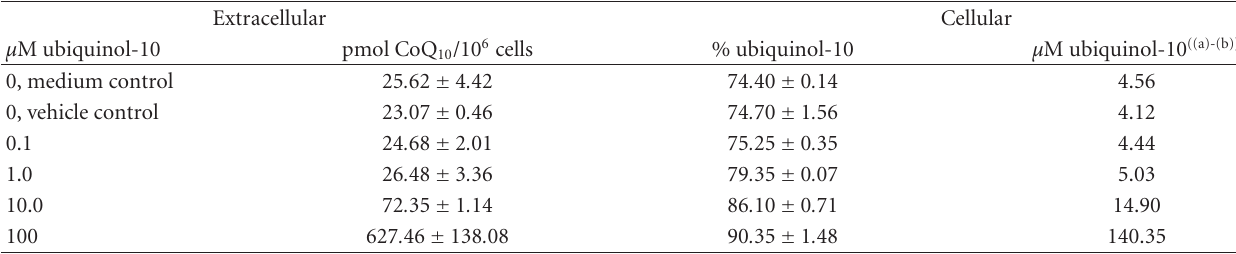
Table 1: Concentration and redox state of CoQ 10 in the human monocytic cell line THP-1 after incubation with various concentrations of ubiquinol-10 for 24 hours. Data are given as means ± SD of two independent measurements performed in